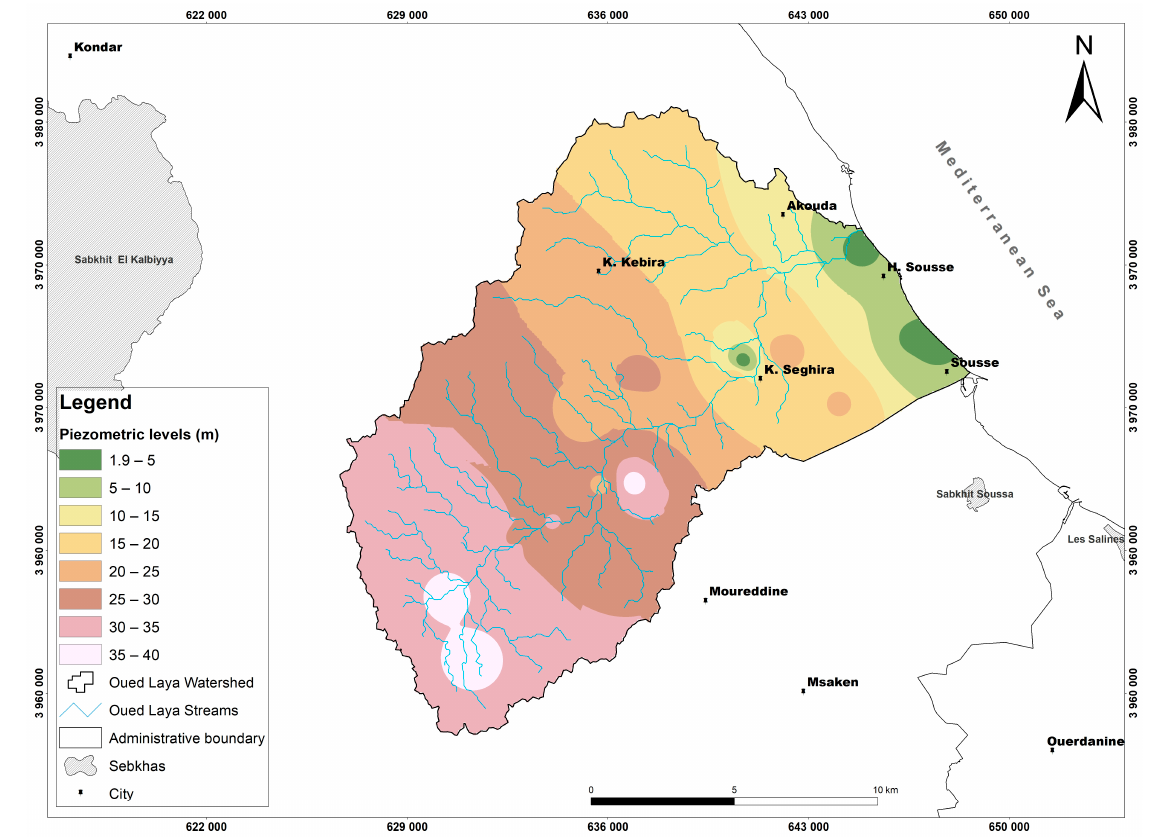
Figure 4. Piezometric map of the shallow aquifer.